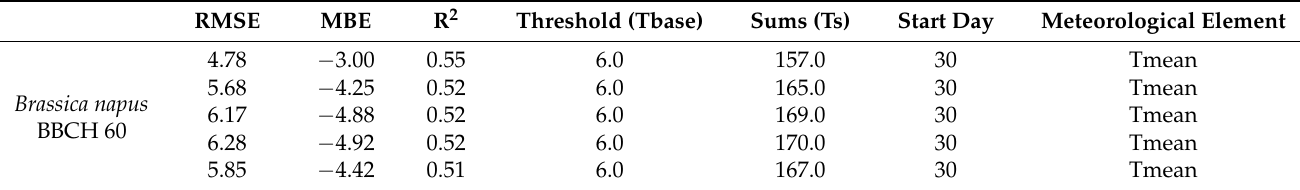
Table 3. Statistical summary for the beginning of flowering (BBCH 60) of Brassica napus validation according to the PhenoClim STT model.